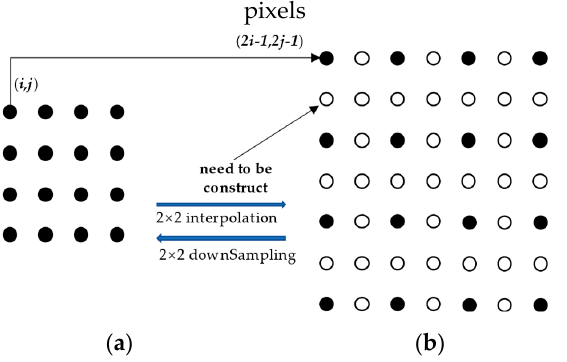
Figure 1. Illustration of the interpolation. The dots denote the known pixels, and the circles denote the missing pixels. ( a ) low-resolution (LR) image; ( b ) high-resolution (HR) image. (𝑖, 𝑗) = 𝐼 (2𝑖 − 1,2𝑗 − 1), 1 (cid:3409) 𝑖 (cid:3409) 𝑀, 1 (cid:3409) 𝑗 (cid:3409) 𝑁 (1) 𝐼 (cid:2896)(cid:2902) (cid:2892)(cid:2902)